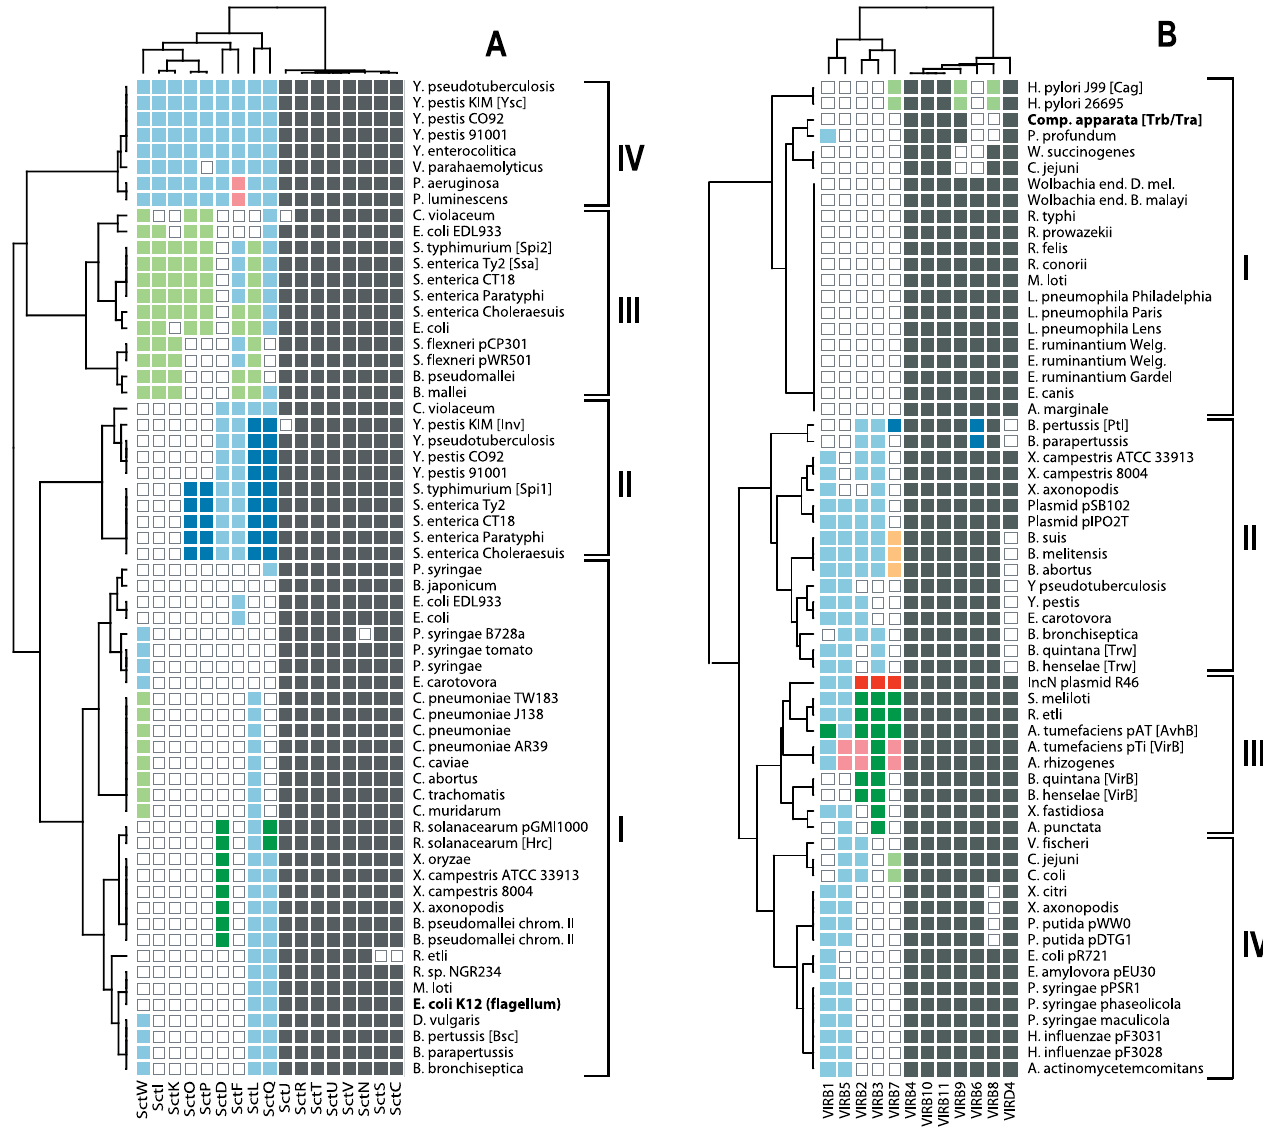
Multiprotein complexes can be classified by considering the presence or absence of part of their components, or their specific variants. Rows represent different T3SS (A) and T4SS (B); columns represent protein functional classes. Different colors identify different PHN-Families. Empty squares indicate absent proteins, while conserved proteins are shown in gray. Two external reference systems ( E. coli flagellar apparatus and a Tra/Trb conjugative system) are marked in bold. The dendrograms represent a hierarchical clustering of the data (for further details and a list of the proteins, see Protocol S1, Table S3, and Table S4) that highlights the presence of four major groups (roman numbers) both in T3SS and T4SS. doi:10.1371/journal.pcbi. 0020173.g008